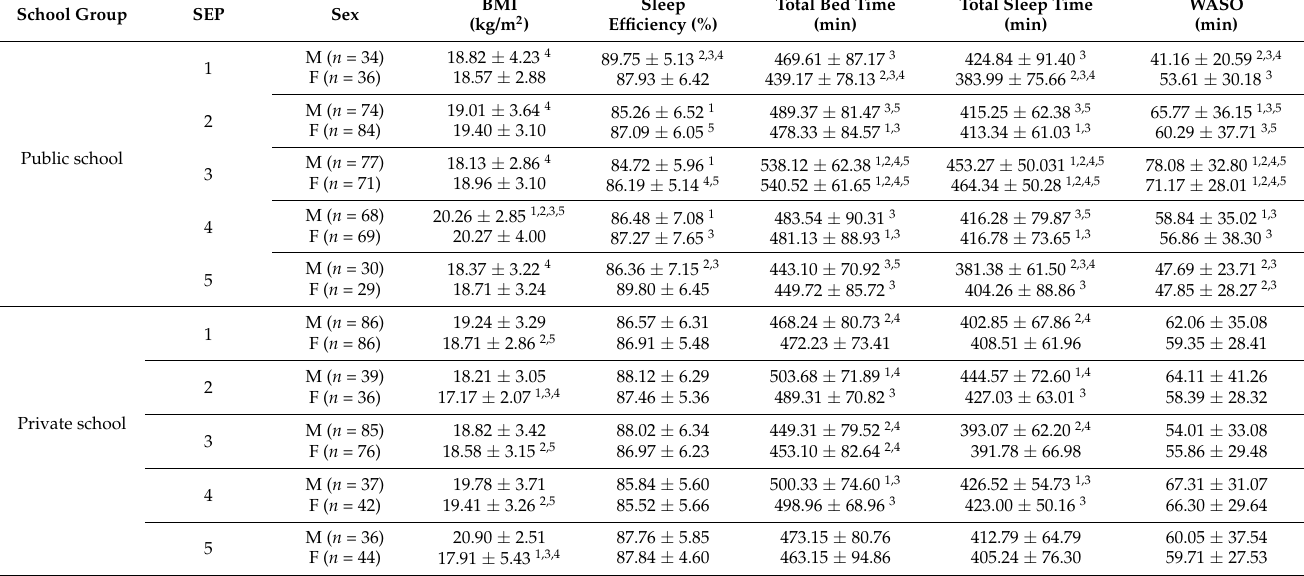
Table 7. Results of the daily sleep quality analysis in each SEP level divided by sex and school titularity 1,2,3,4,5 .